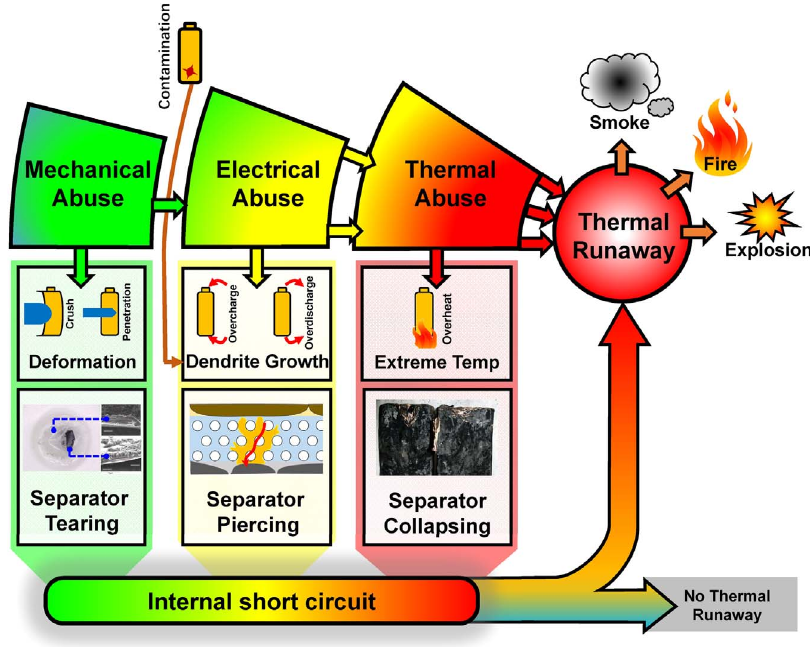
Figure 10. Main factors and internal relationship of thermal runaway inducements